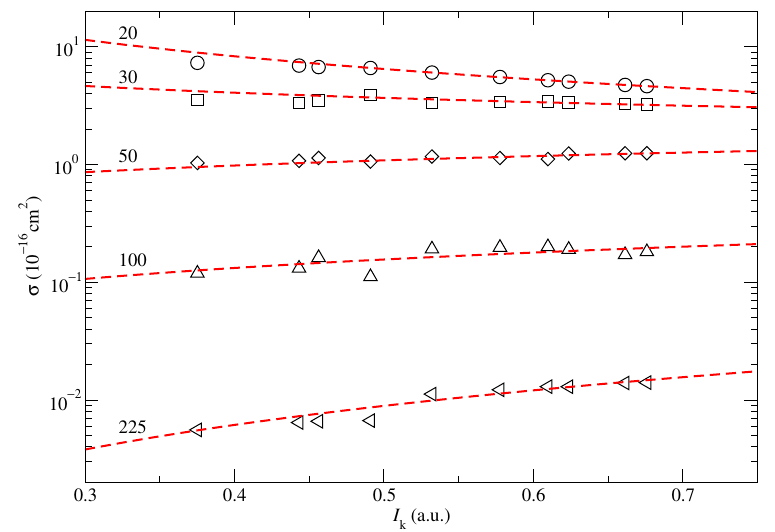
Figure 7. Same as in Figure 6, but for the single charge transfer